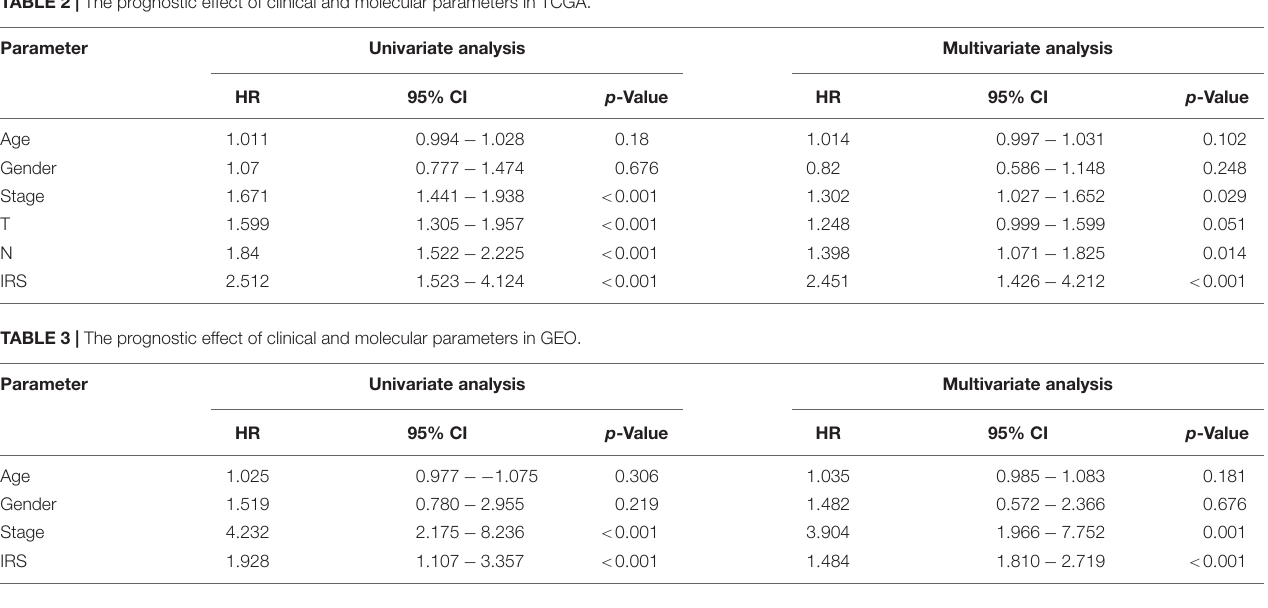
FIGURE 4 | IRS analysis of prognosis models of 3 immune genes in TCGA and GSE31210 datasets. (A) The survival curves of low-risk and high-risk group in TCGA. (B) The ROC curve for predicting OS of patients based on the IRS to in TCGA. (C) The expression heatmap of three immune prognostic genes in the low-risk and high-risk group from TCGA. (D) IRS distribution and survival status of patients in the low-risk and high-risk group from TCGA. (E) The survival curve of low-risk and high-risk group in GSE31210. (F) The ROC curve for predicting OS of patients based on IRS in GSE31210. (G) The expression heatmap of three immune prognostic genes in the low-risk and high-risk group from GSE31210. (H) IRS distribution and survival status of patients in the low-risk and high-risk group from GSE31210. TABLE 2 | The prognostic effect of clinical and molecular parameters in TCGA.